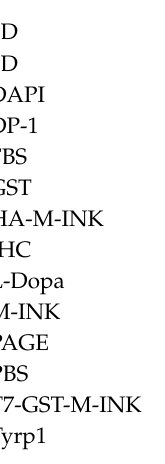
Supplementary Materials: The following are available online at http: // www.mdpi.com / 1422-0067 / 21 / 22 / 8514 / s1, Figure S1: Immunostaining images of HA-M-INK and Pmel in B16 melanoma cells. Author Contributions: C.Y.-M., Y.M., A.R., E.N., T.T., and M.F. conceived and designed the experiments.